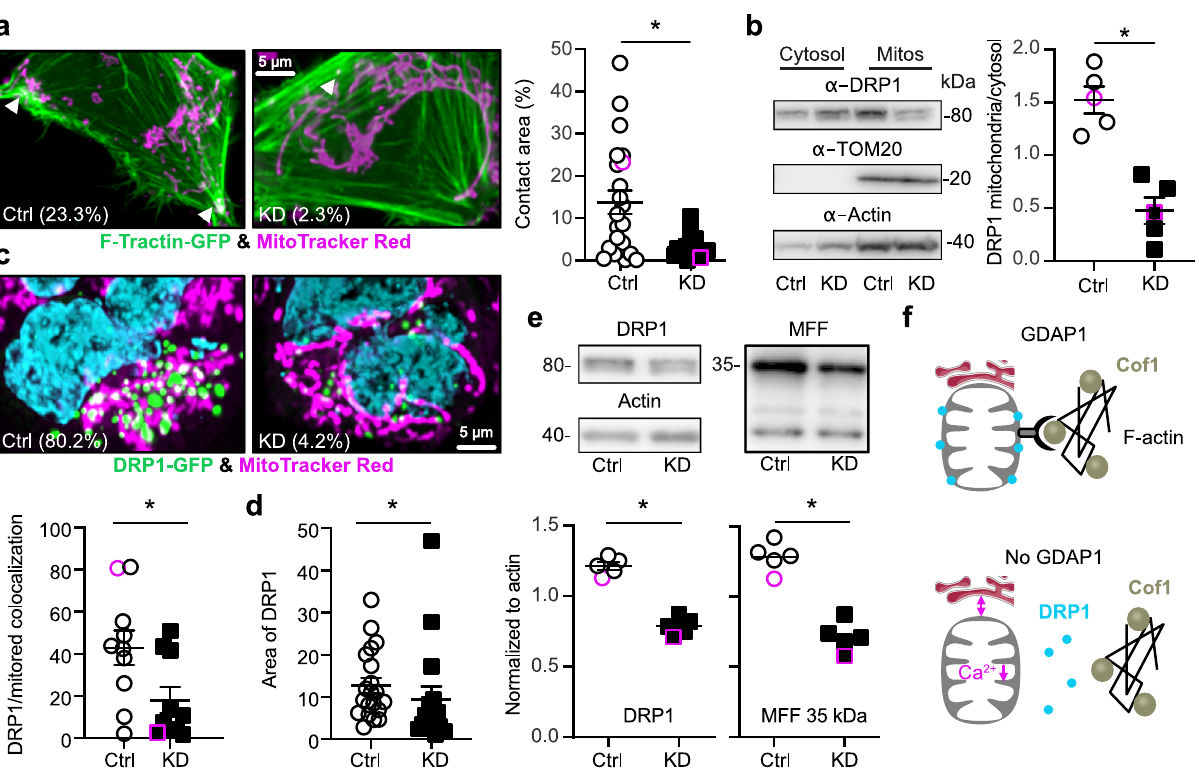
Fig. 8 GDAP1 KD reduces F-actin fi bers at mitochondrial surfaces and restricts access of DRP1 to the mitochondria resulting in less DRP1 and MFF. a Live cell imaging of GFP-F-tractin transfected cells. Mitochondria were stained with MitoTracker and images analyzed for contact area using Imaris. b Immunoblot of DRP1 in cytosolic and mitochondrial fractions demonstrating a reduced DRP1 abundance in mitochondrial fractions. TOM20 and actin served as loading controls, size is indicated. c , d Live cell imaging of GFP-DRP1 transfected cells. Mitochondria were stained with MitoTracker and images analyzed for ( c ) colocalization and ( d ) area. e Immunoblot of total DRP1 and MFF demonstrating a reduced abundance of both proteins. Actin served as loading control, size is indicated. f Scheme depicting our fi ndings. Cof1, Co fi lin-1. In the absence of GDAP1 mitochondrial F-actin is reduced resulting in an increased distance between ER and mitochondria, reduced mitochondrial Ca 2 + levels, and a reduced presence of DRP1 at mitochondrial constriction sites. Data from ( a ) are from n = 19 cells per cell line from three independent experiments performed in triplicates. Data from ( c ) are from n = 10 and ( d ) from n = 16 cells per cell line from three independent experiments. Data points corresponding to the examples are highlighted. Statistical variation is shown as scatter plots with the indication of mean ± SEM and signi fi cance calculated using the non-parametric Mann – Whitney test, * p <